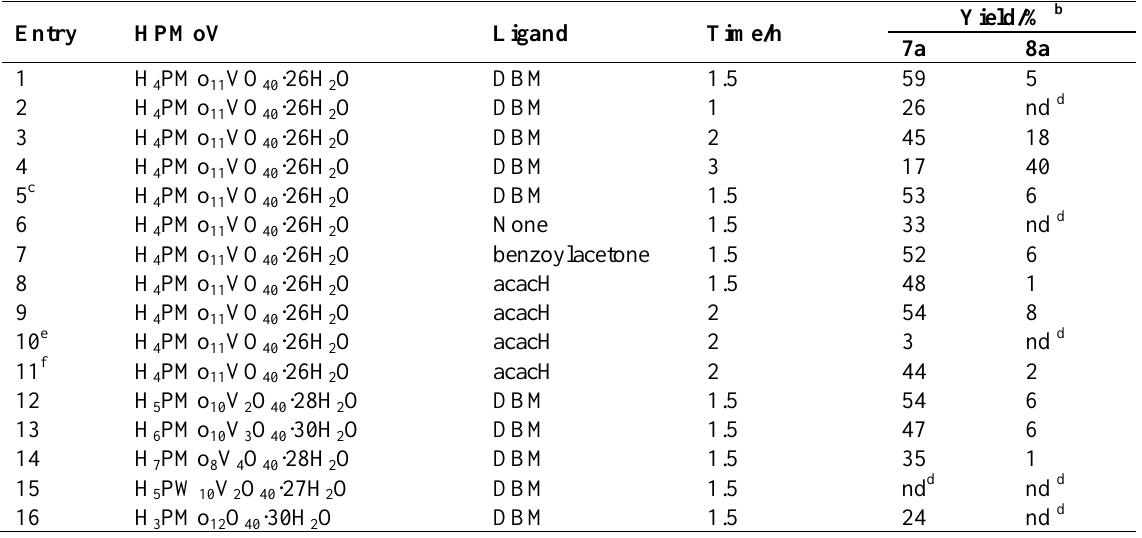
Table 3. Oxidative coupling of benzene ( 1a ) with acrolein ( 6a ) catalyzed by Pd(II)/HPMoV. a